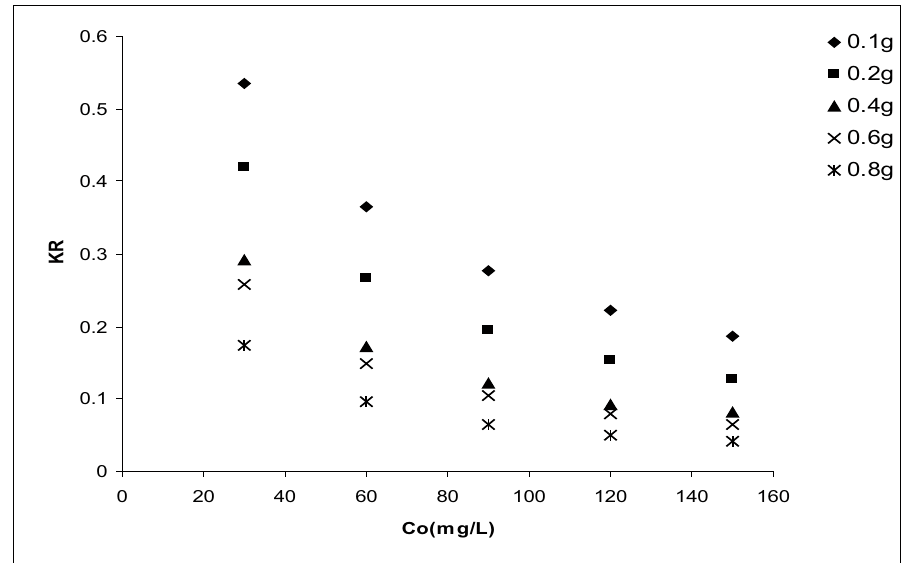
Figure 4. Relationship between the separation factor, K